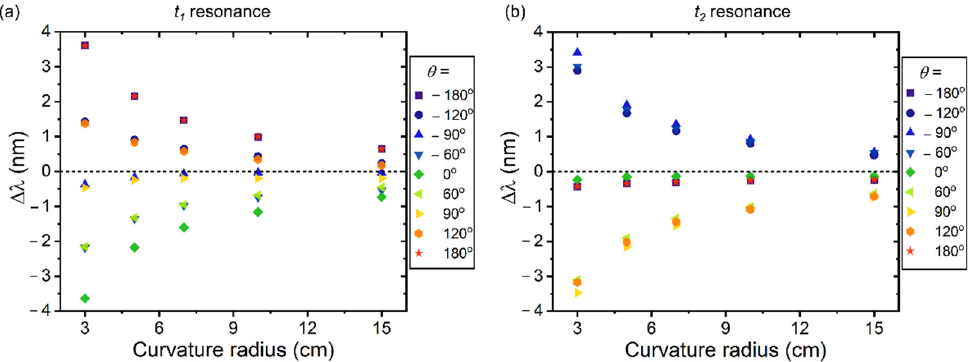
Figure 3. Wavelength shifts ( ∆ λ ) associated with the tubes with thicknesses ( a ) t 1 and ( b ) t 2 as a function of the curvature radius tube for representative curvature angles, θ .